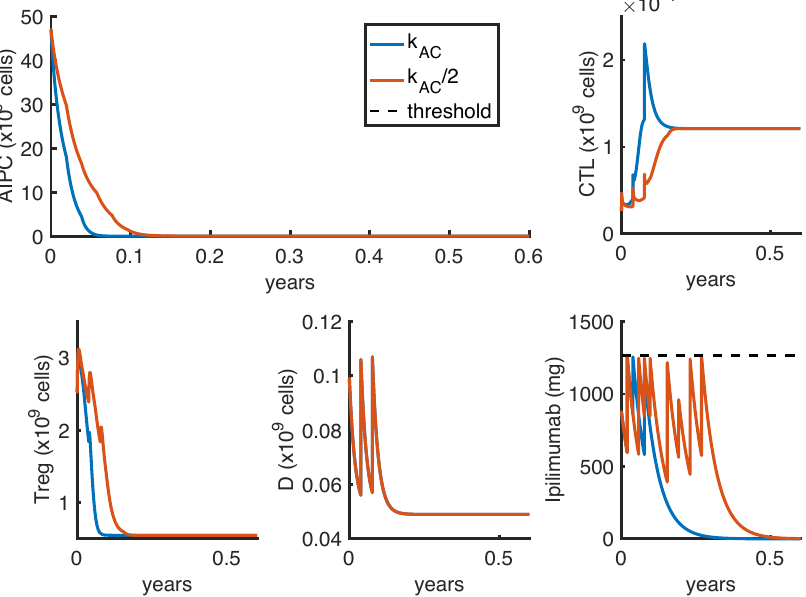
Figure A2. Comparison between administration protocols obtained with different values of the parameter k AC . The dynamics refer to the ipilimumab and sipuleucel-T combination therapy as result of the optimization problem OP2, with ∆ t = 1 week. Blue lines represent the model outcomes with the estimate value of k AC (the same presented in Figure 5, orange line), while orange lines represent the one with k AC . The ipilimumab threshold has been highlighted with a black dotted line.